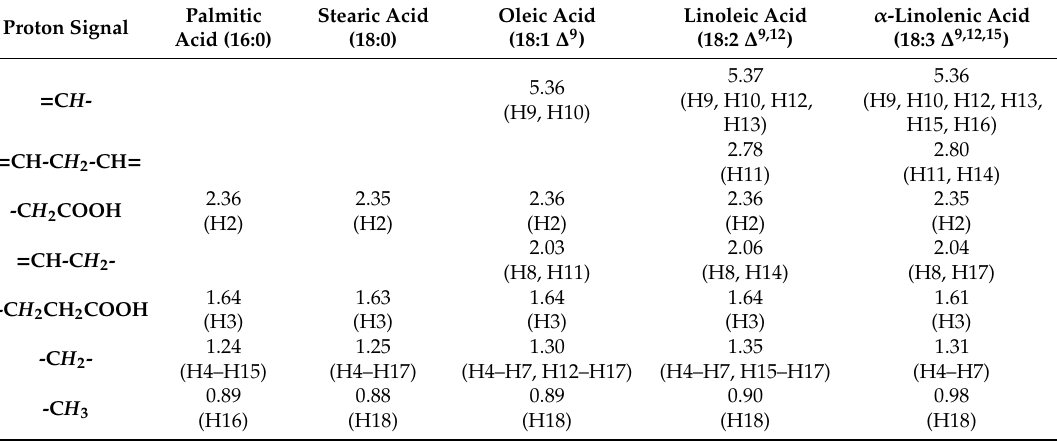
Figure 1. Structures of selected fatty acids present in waste cooking oils (WCO). Table 1. 1 H chemical shifts of selected fatty acids present in WCO